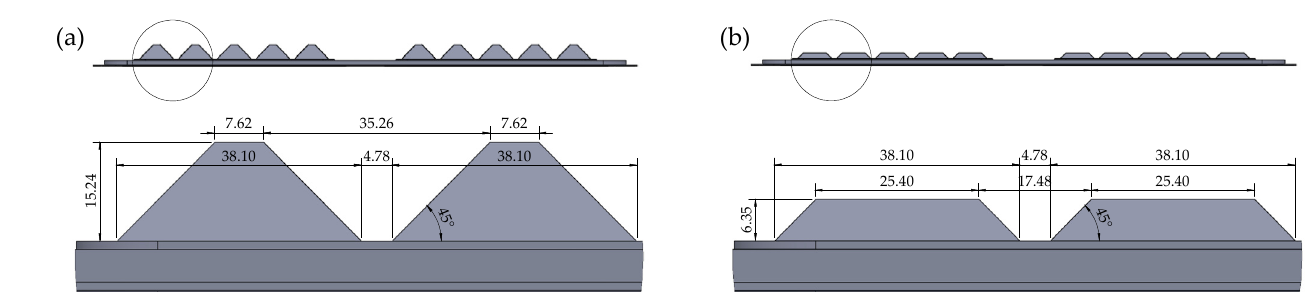
Figure 3. Designs of PCM panels for the pyramidical (PY) configuration with different frustrum heights: ( a ) h = 15.24 mm, ( b ) h = 6.35 mm.